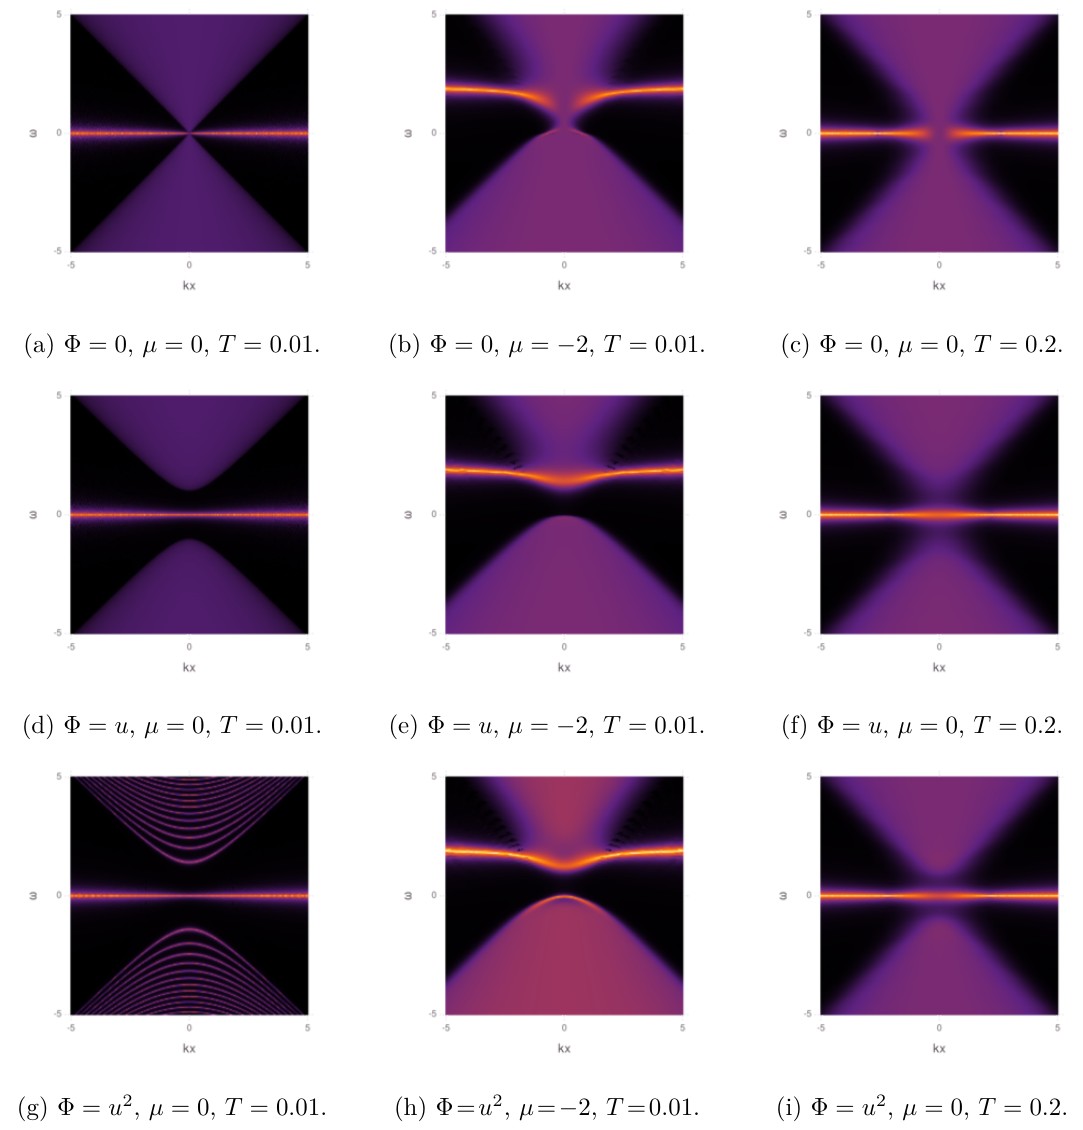
Figure 6 . The effects of chemical potential ((b), (e), (h): the 2nd column) and temperature ((c), (f), (i): the 3rd column). The first row figures ((a), (b), (c)) are for Φ = 0 . The second row ((d), (e), (f)) is for the scalar source, the third row ((g), (h), (i)) are for the scalar